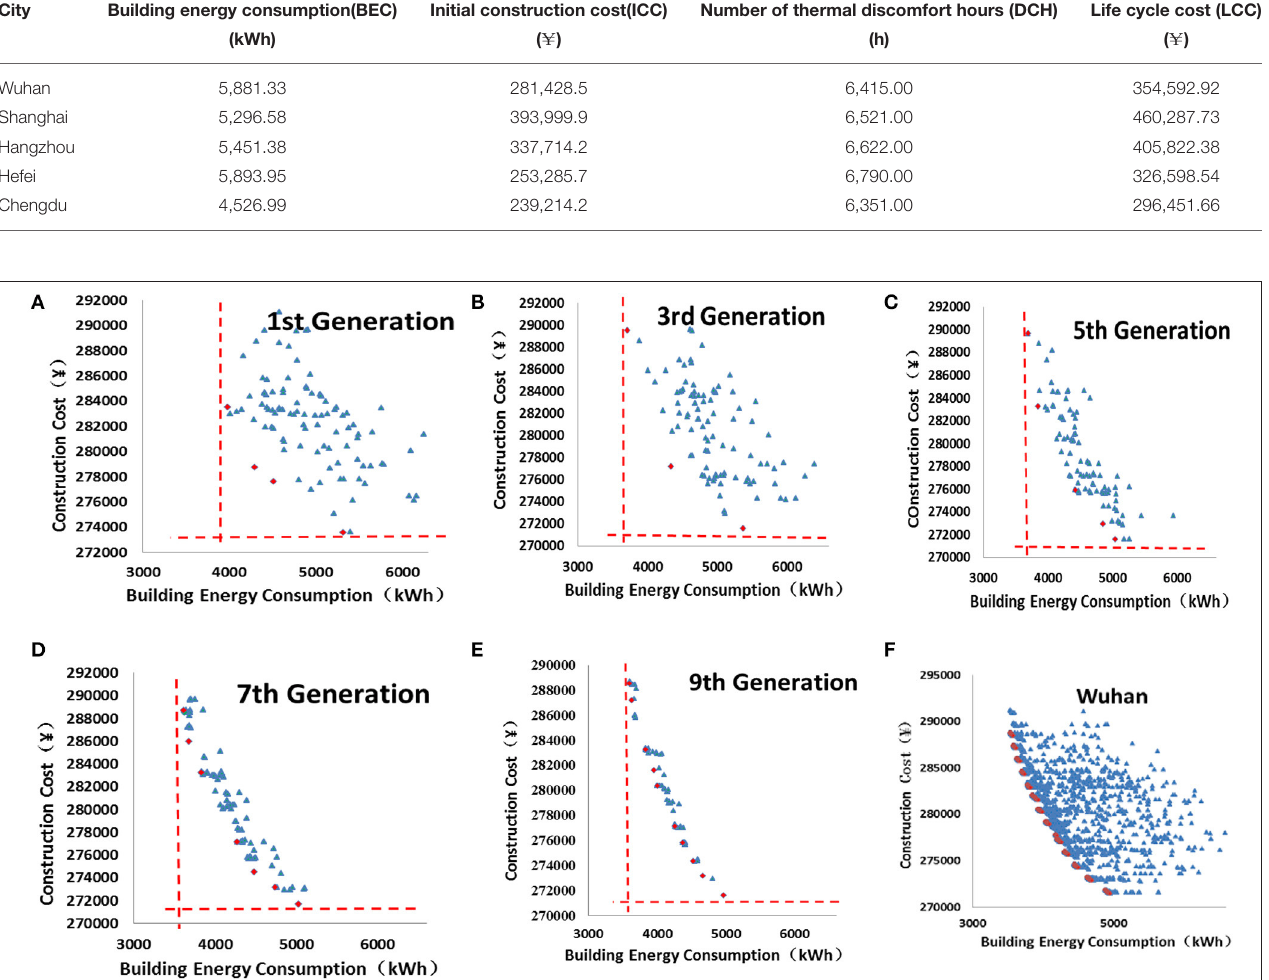
FIGURE 5 | (A) The distribution of initial population. (B) The distribution of the 3rd population. (C) The distribution of the 5th population. (D) The distribution of the 7th population. (E) The distribution of the 9th population. (F) Pareto solutions and the individuals in the sample